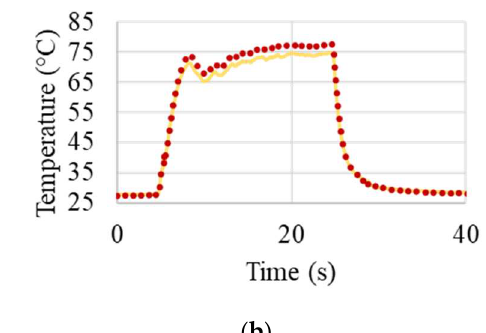
Figure A1. Temperature waveforms of the measurements at different heating currents: ( a ) 200 mA; ( b ) 190 mA; ( c ) 180 mA; ( d ) 170 mA; ( e ) 160 mA; ( f ) 150 mA; ( g ) 140 mA; ( h ) 130 mA; ( i ) 120 mA; ( j ) 110 mA; ( k ) 100 mA. Sample diameter, 100 μm.